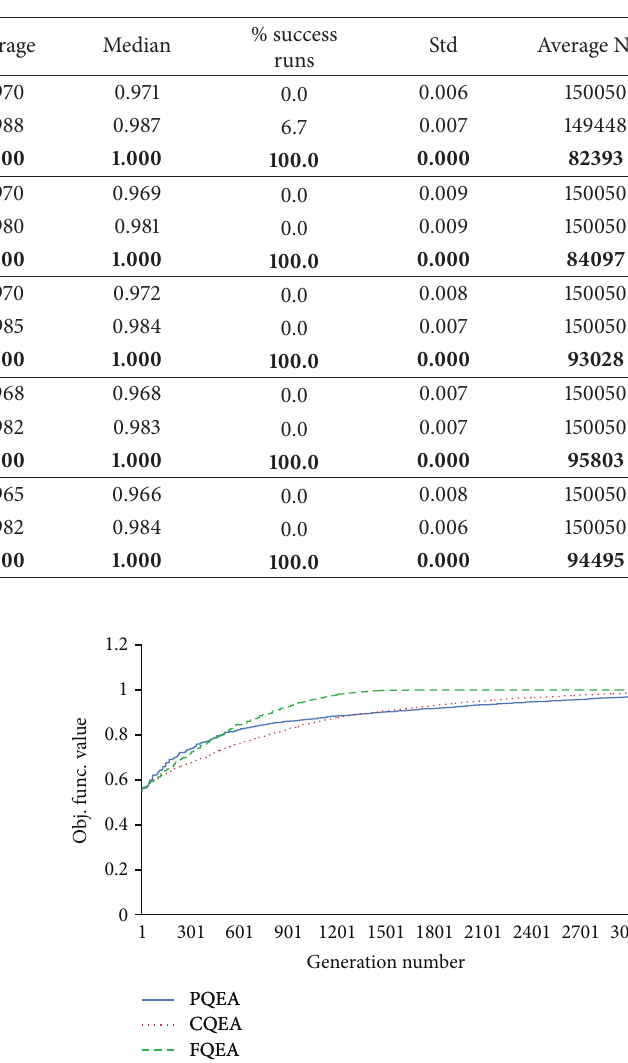
Table 3: Comparative study between PQEA, CQEA, and FQEA using statistical results on 𝑃 -PEAKS problem instances with size 𝑁 as 1000.